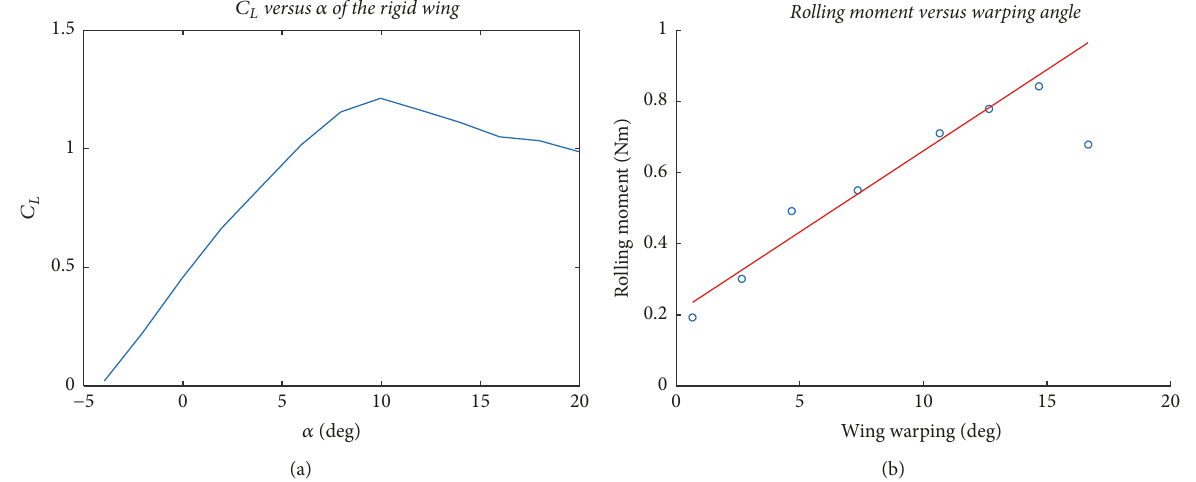
Figure 12: Wind tunnel test results: (a) aerodynamic property of rigid wing; (b) the rolling moment of FMW.